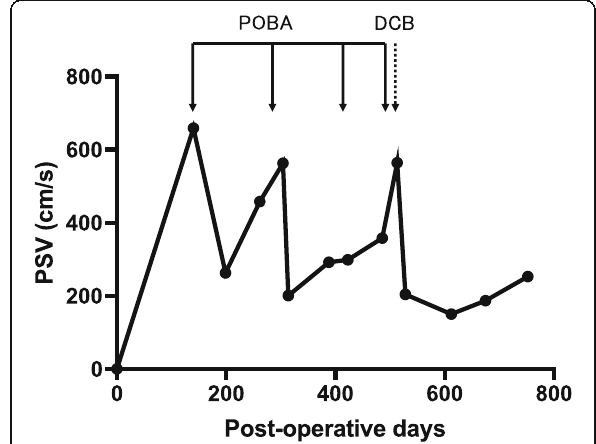
Fig. 2 Change in the peak systolic velocity (PSV) of the vein graft postoperatively. The solid arrows show angioplasty with a plain balloon and the broken arrow shows angioplasty with a drug- coated balloon. The change in PSV of the vein graft after surgery is shown on the